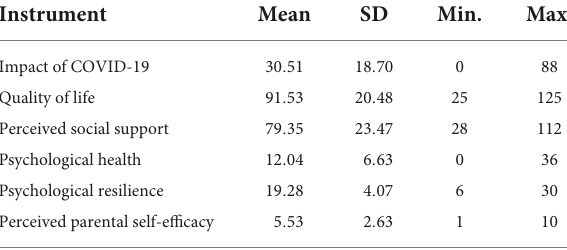
TABLE 4 Descriptive statistics ( N = 824).